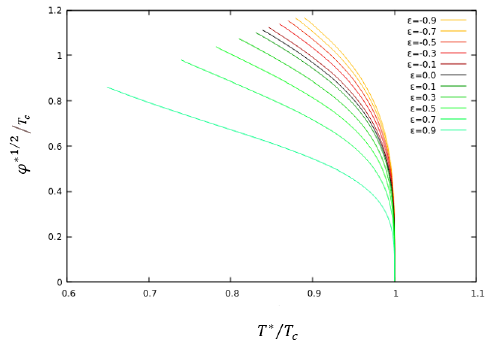
Figure 4. The condensate ϕ 1/2 + / T c for a balanced superconductor as a function of T / T c for λ = 0 and several values of (cid:101)